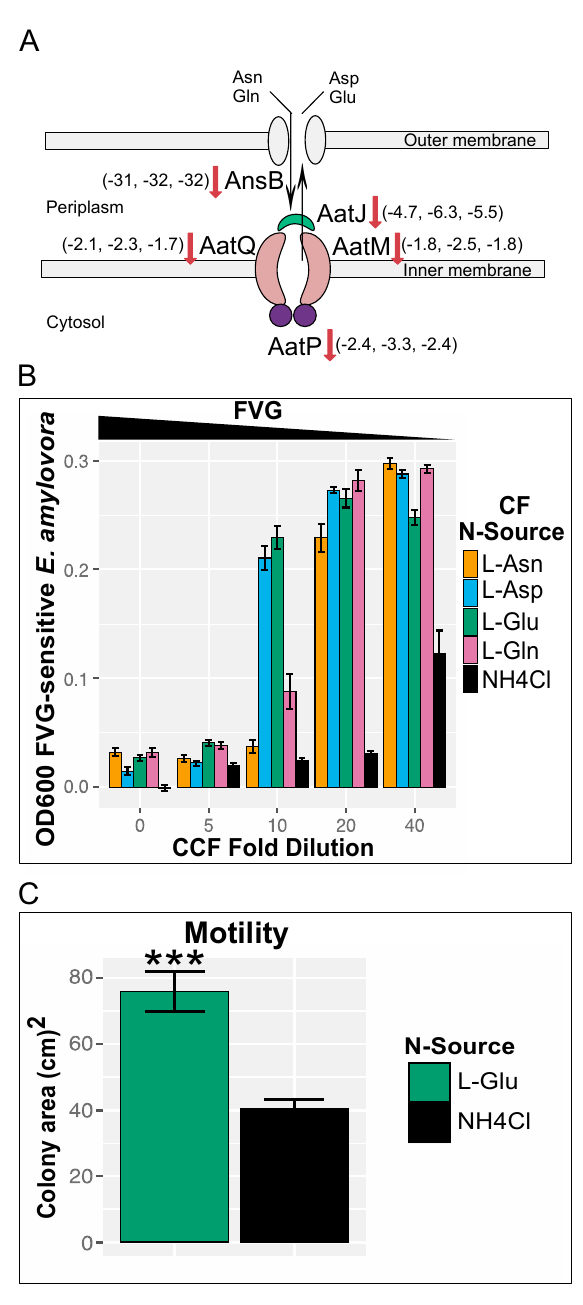
Figure 6. Downregulation of FVG production by acidic amino acids and their amides. ( A ) Schematic of uptake pathway of acidic amino acid and the regulation of pathway genes in gvg cluster mutants. The numbers in the brackets next to the gene product represent the fold difference from WT of ∆ gvgR , A , and C , respectively. ( B ) Growth inhibition of E. amylovora by FVG in culture filtrates (CF) of WH6 grown in alternative N-sources. Bars represent the average of three independent experiments with six replicates each. ( C ) Swimming motility of WH6 grown in alternative N-sources after 6 days of growth. Bars represents the average colony area of three independent experiments with four to five replicates each. Error bars = standard error. *** = p ≤ 0.001 by Student’s